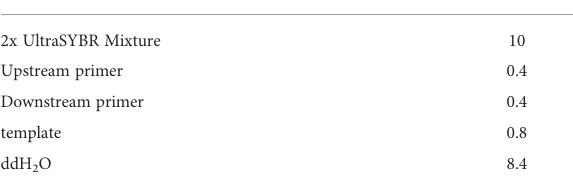
TABLE 1 qRT-PCR reaction